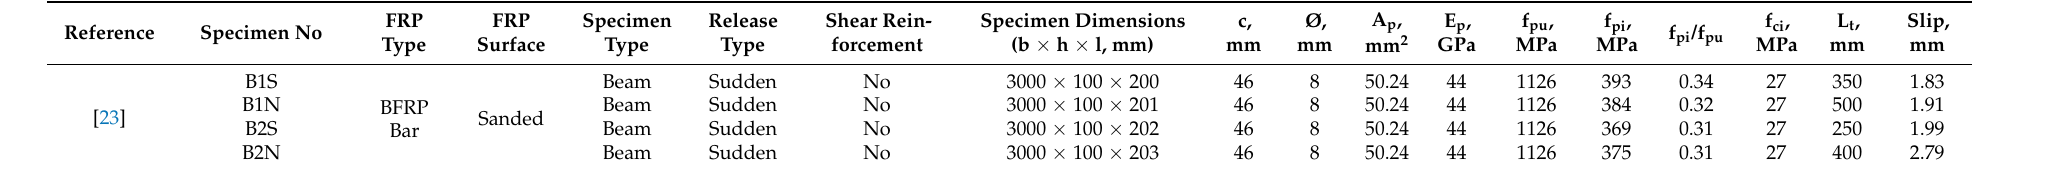
Table A4. Experimental parameters of specimens with pretensioned BFRP